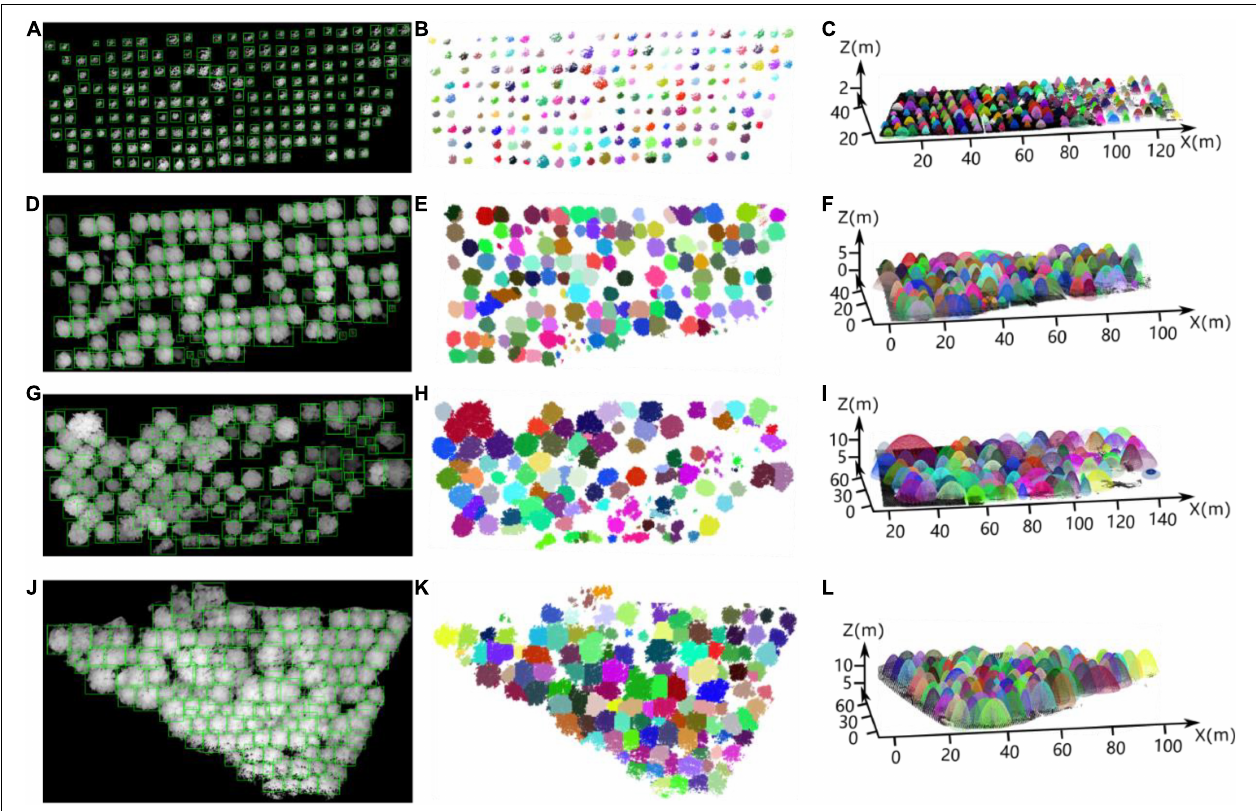
FIGURE 15 | Individual tree crown detection results via our deep learning network for the partial testing set of heightmaps for the (A) nursery, (D,G) forest landscape area, and (J) mixed tree plantation. (B,E,H,K) Correspond to (A,D,G,J) , respectively, which intuitively display the ITC detection results for the four study sites. (C,F,I,L) Show the results of elliptic parabolic fitting for each tree in the four plots, corresponding to (A,D,G,J) , respectively.